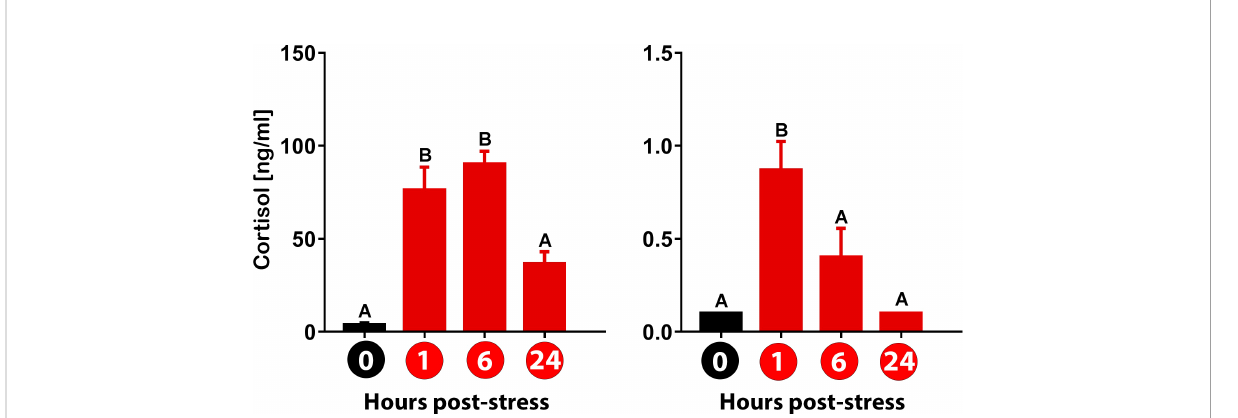
FIGURE 1 Detection of cortisol levels in plasma and skin mucus for gilthead sea bream ( Sparus aurata ) subjected to three-minute air exposure stress. Values for (A) plasma and (B) skin mucus at 0, 1, 6, and 24 hours post-stress (hps) are plotted. Values (ng/ml) are presented as mean ± standard error (n = 8 fi sh per sample type and time evaluated). Signi fi cant differences between times are represented in capital letters (One-way Anova; p<0.05). Different colored bars indicate different treatments: black (control group) and red (air exposure-stressed